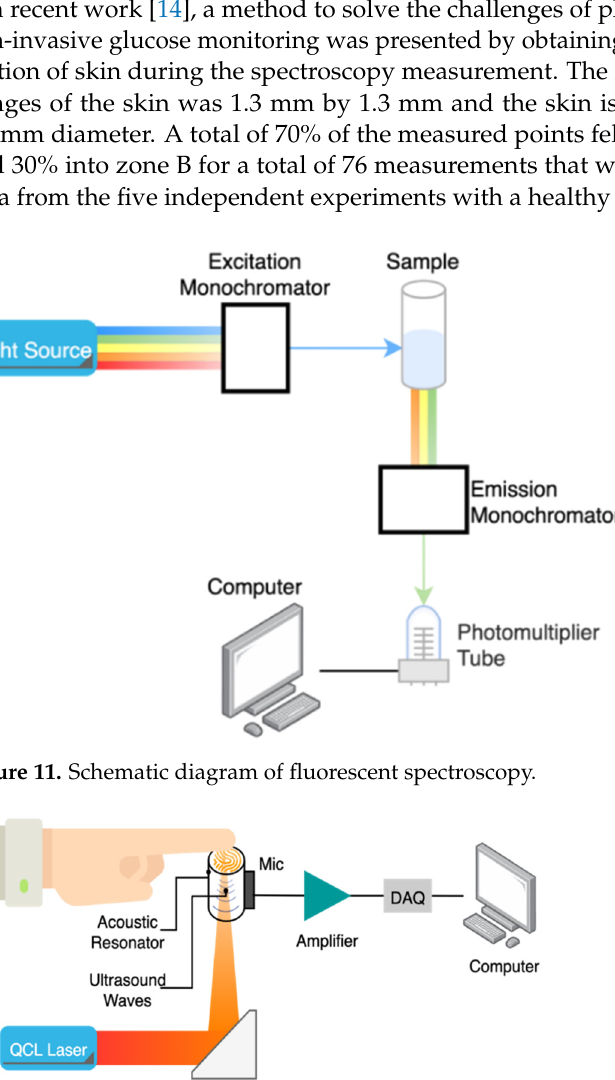
Figure 13. Photoacoustic spectroscopy system: ( a ) schematic diagram, ( b ) optical micrograph and photoacoustic image of SU-8 structures for resolution evaluation, ( c ) reflected beam diameter from the parabolic mirror, and ( d ) PAS peak signal that is located at 47.5 kHz with a reference carbon black tape sample. Reprinted with permission from [14].